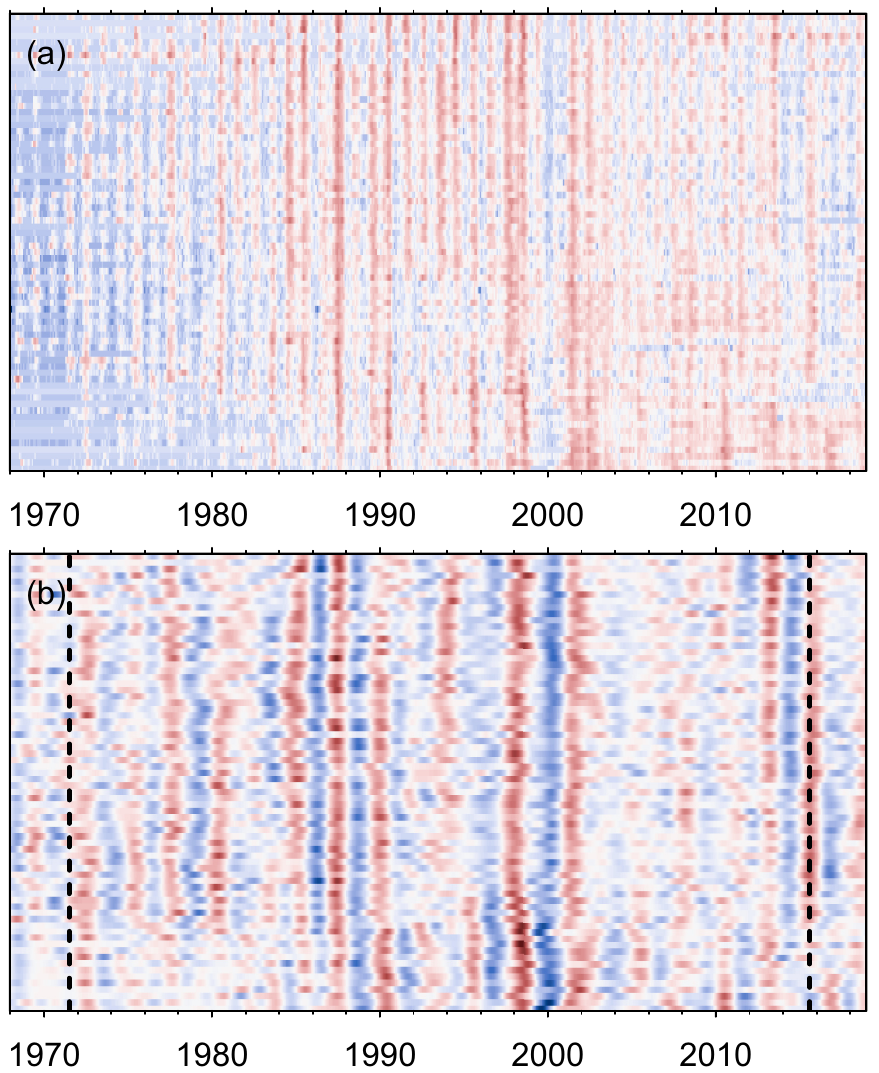
Fig 1. Dengue multiannual cycles. Heatmaps of (a) ln number of cases and (b) reconstructions of time series using multiannual components only, per province arranged from north (top) to south (bottom). To improve clarity, values for each province were normalised to a mean of 0 and a standard deviation of 1 in both panels. Blues (respectively reds) are lower (respectively higher) numbers, and whites correspond to the mean for each province. Edge effects in the WTs may influence results before and after the vertical dashed lines in (b) (see section “Materials and methods”). The underlying data are in S1 Data at https://github.com/UF-IDD/synchrony_dengue_figures. WT, wavelet